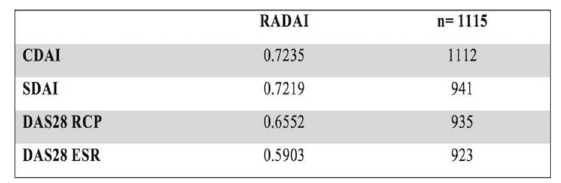
Table 1 (abstract P372). Agreement between the DACIs - DACIs: Disease Activity Composite Indexes; CDAI: Clinical Disease Activity Index; DAS28: Disease Activity Score 28 joints; SDAI: Simplified Disease Activity